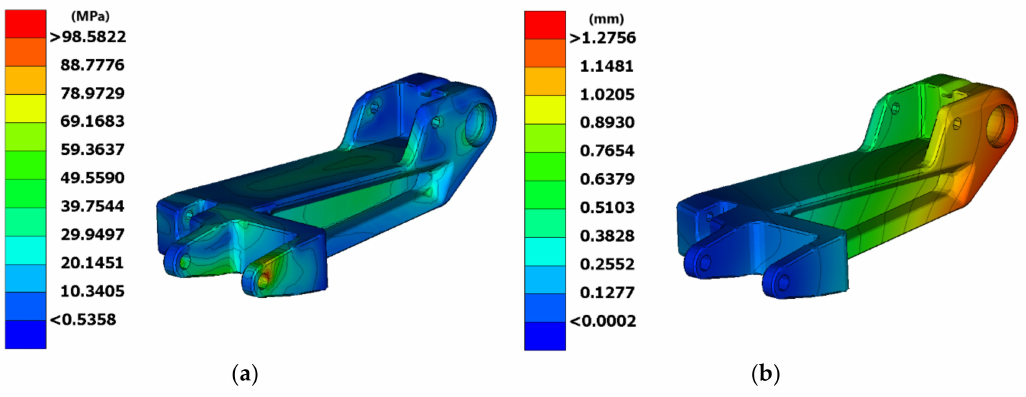
Figure 10. Stress ( a ) and displacement ( b ) results in 2nd loading